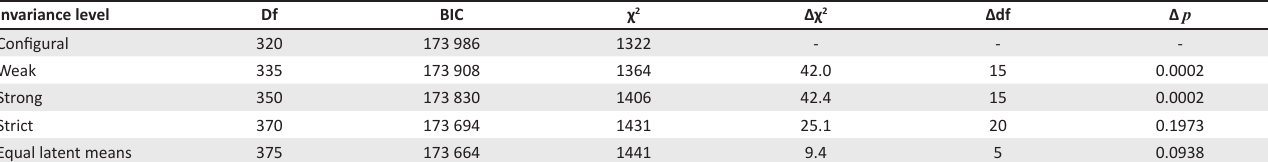
TABLE 2: Chi-square test and change in chi-square statistics. Invariance level